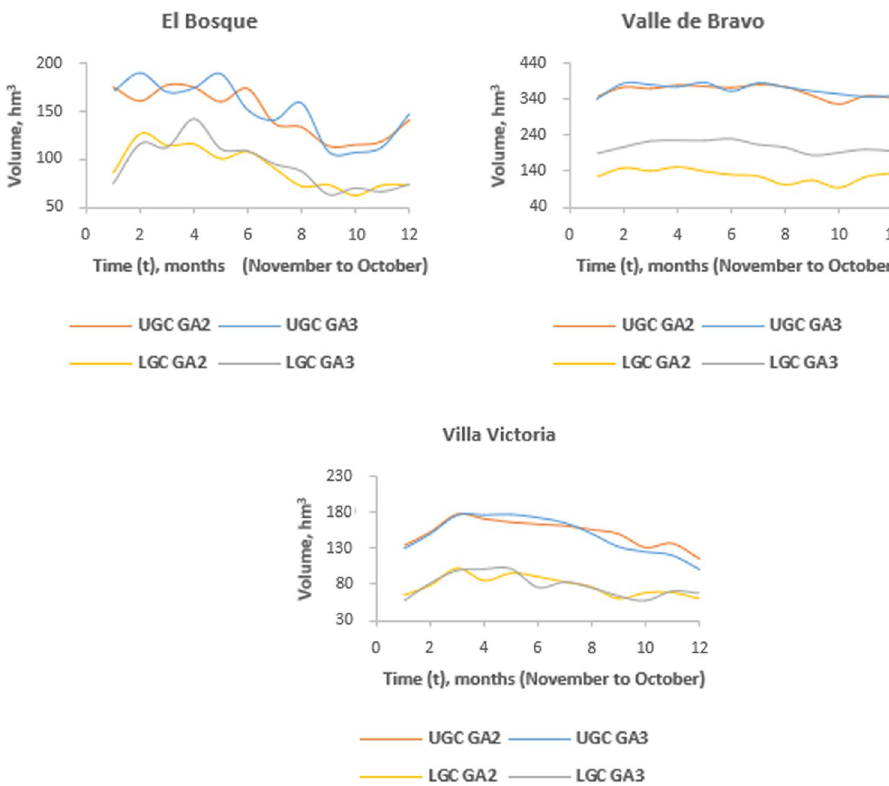
Fig. 15 The upper limit guide curve (UGC) and lower limit guide curve (LGC) for GA3 versus GA2 policy